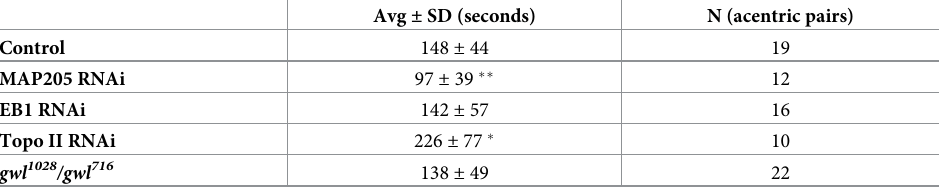
Table 2. Sister separation of acentrics is delayed relative to sister separation of intact chromosomes. Average time (in seconds) for sister acentrics to initiate separation after sister kinetochore-bearing chromosomes separated. Time (average ± SD) measured from initiation of intact chromosome separation to initiation of acentric sister chromosome separation. Asterisks indicate statistical significance ( �� P = 0.001, � P = 0.003) as determined by two-sided Mann-Whit- ney